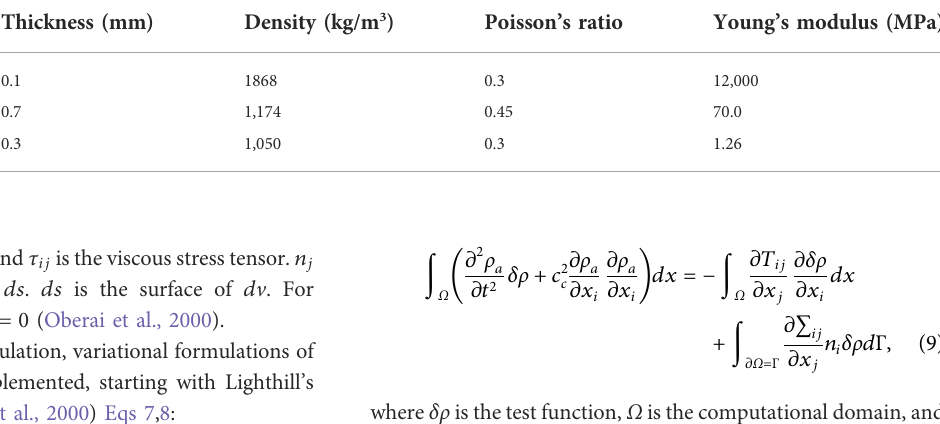
TABLE 2 Mechanical properties of components used for boundary condition settings.